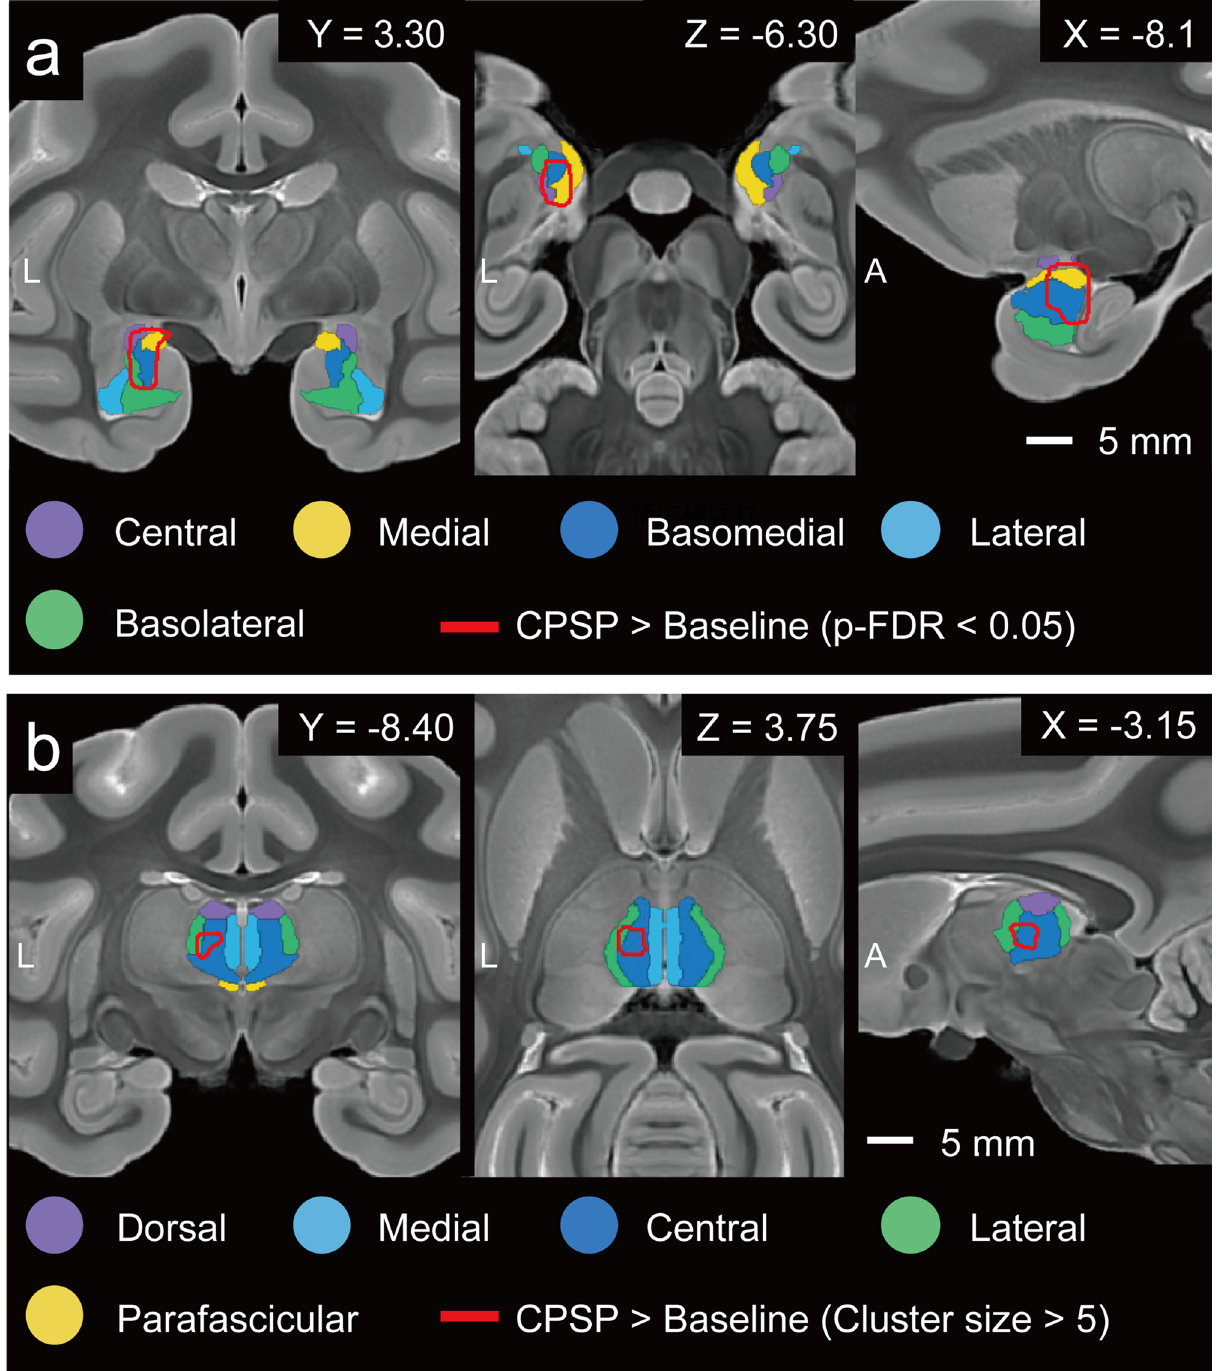
Figure 5. Detailed connectivity between the mediodorsal nucleus (MD) of the thalamus and amygdala obtained from seed-to-voxel analyses. Coronal (left), axial (centre), and sagittal (right) slices of the T2-weighted macaque atlas are shown. ( a ) Results of seed-to-voxel analysis when the MD is selected as the seed. The red lines indicate the edge of the voxel clusters in which the functional connectivity is significantly changed (voxel level uncorrected p < 0.001 and cluster level p -FDR < 0.05). The coloured areas indicate subregions of the amygdala drawn by using the template atlas. ( b ) Results of seed-to-voxel analysis when the amygdala is selected as the seed. We adjusted the significance level of the cluster size to detect focal changes (cluster size > 5). Coloured areas indicate the nucleus of the thalamus, drawn by using the template atlas. The xyz coordinate is defined at the anterior commissure. A anterior, CPSP central poststroke pain, L